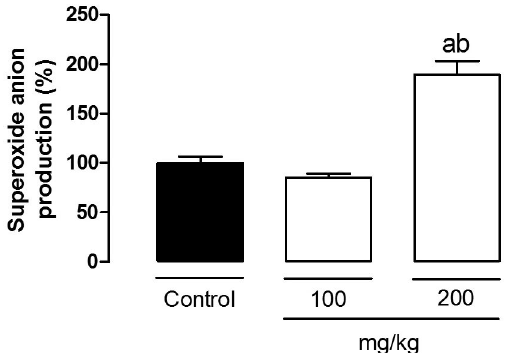
FIGURE 5 - Superoxide anion production of resident macrophages from mice fed regular chow (Control Group), treated with 100 mg/kg b.w. of CLD (Group 100), and 200mg/kg b.w. (Group 200). a p<0.001 compared to Control. b p<0.001 compared to 100. Results are presented as % relative to control.